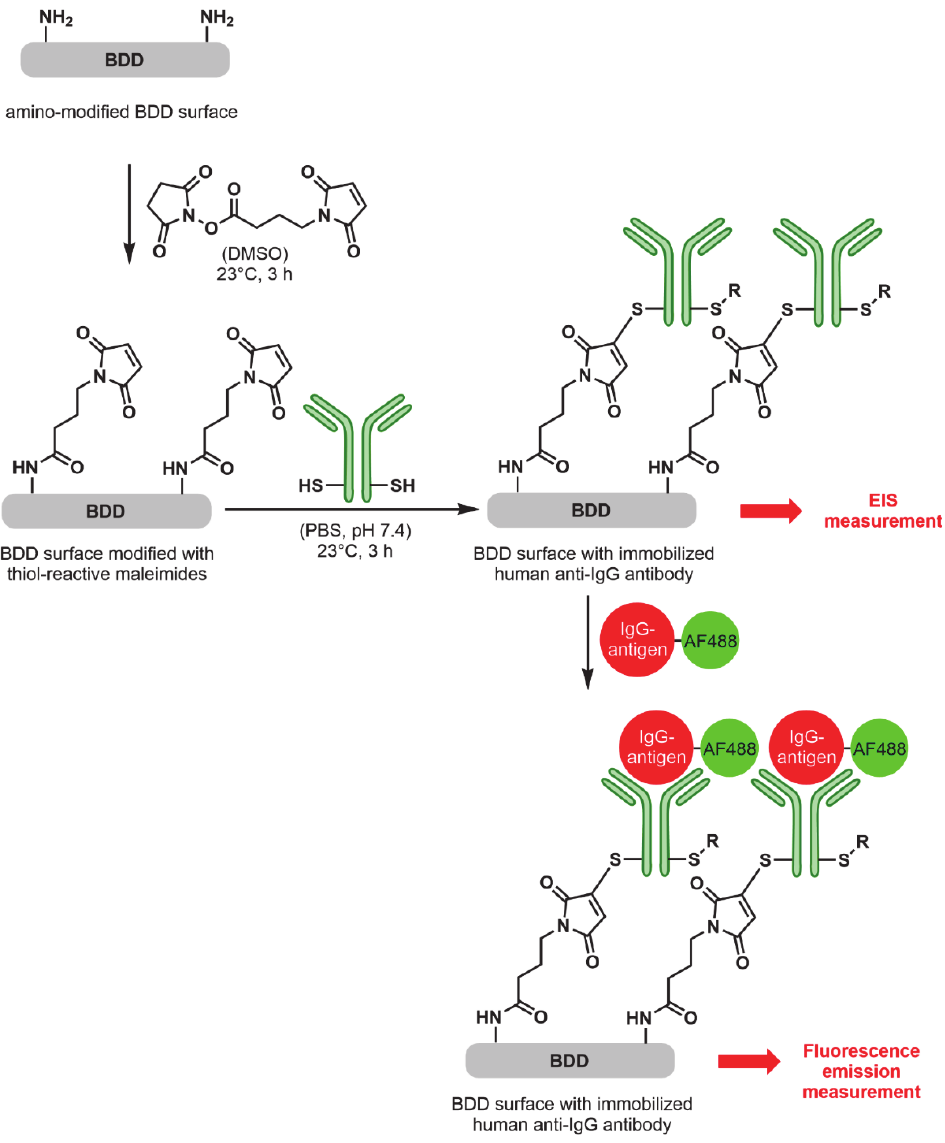
Figure 1. Overview about immobilisation of antibody on the surface of the working electrodes.